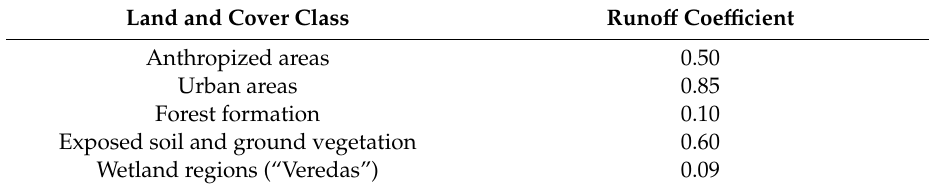
Table 7. Runo ff coe ffi cients for each land use and cover class in the Pandeiros River basin. Adapted from the ASCE—American Society of Civil Engineers, 1969, and Costa et al., 2019 [10,60].